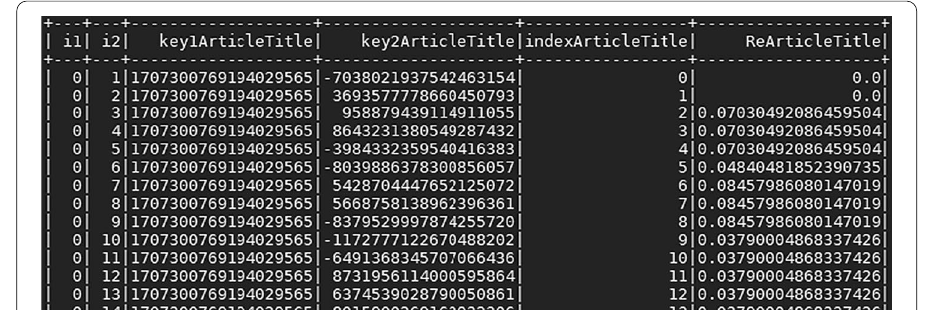
Fig. 5 Matrix of the criteria of the